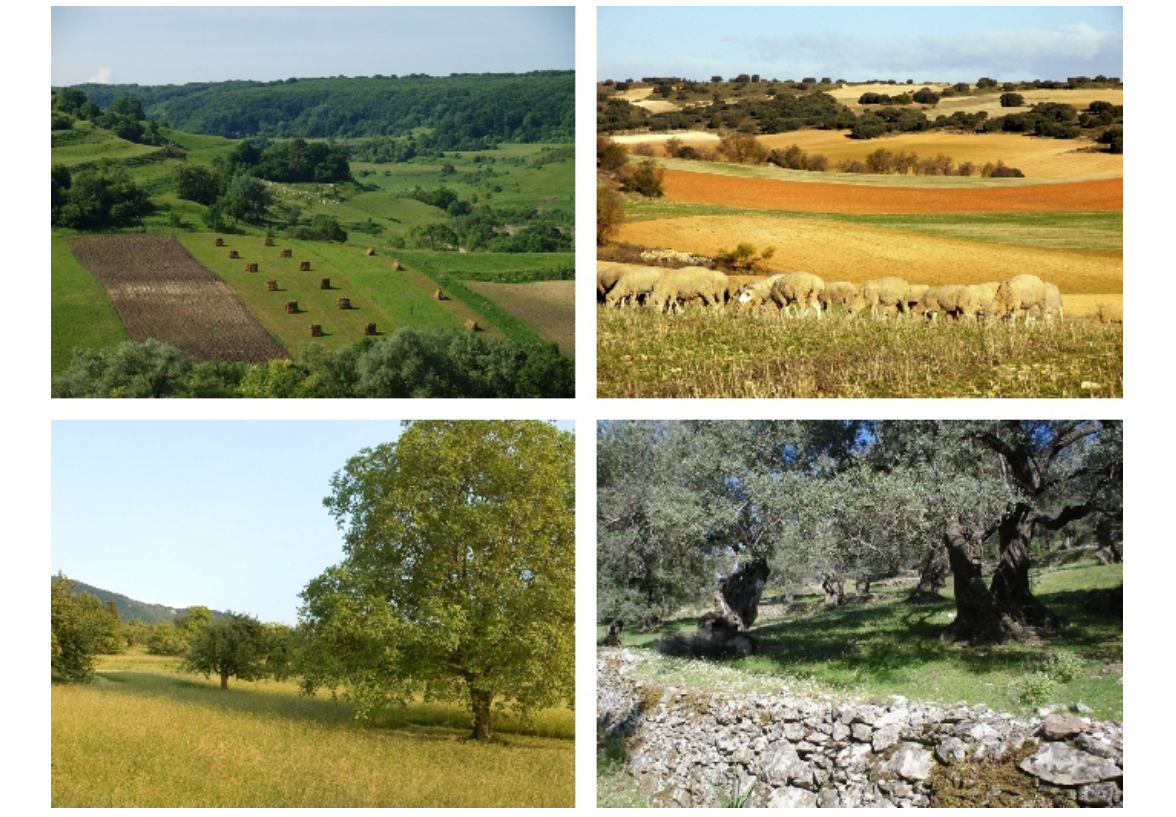
Fig. 4 . Examples of typical HNV (high-nature-value) land-use systems in Europe (from upper left to lower right): a) Traditional hay meadows and pastures in the Saxony region of Romania; b) Low-intensity, small-scale farming/grazing in Castilla-La Mancha, Spain; c) Traditional orchards with permanent seminatural understory in Southern Germany; d) Mediterranean dryland olive crops on Lesvos Island, Greece. Courtesy of Tibor Hartel (a), Berta Martín López (b), Ursel Maichle-Schmitt (c), and Thanasis Kizos